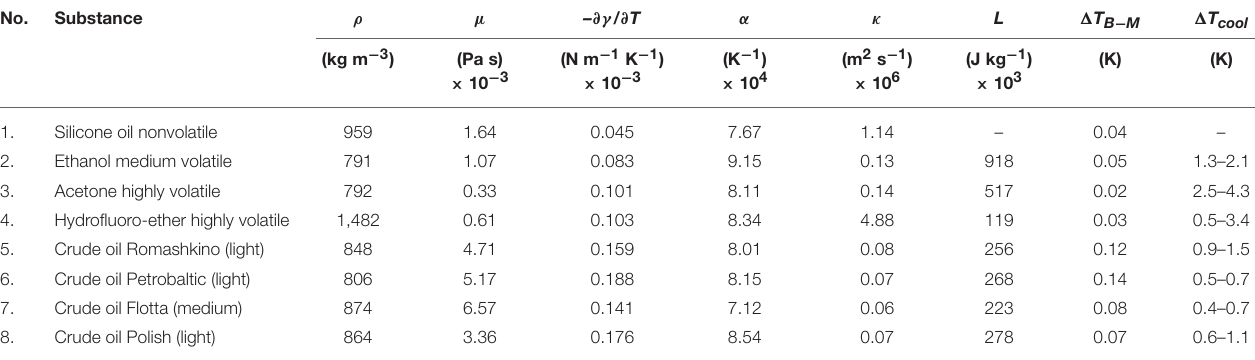
TABLE 1 | Thermal and physical properties of studied liquids vs. critical threshold temperature difference 1 T B − M predicted to onset B-M circulation in thin layers at ambient conditions ( T = 23 ◦ C) and experimental evaporative cooling 1 T cool